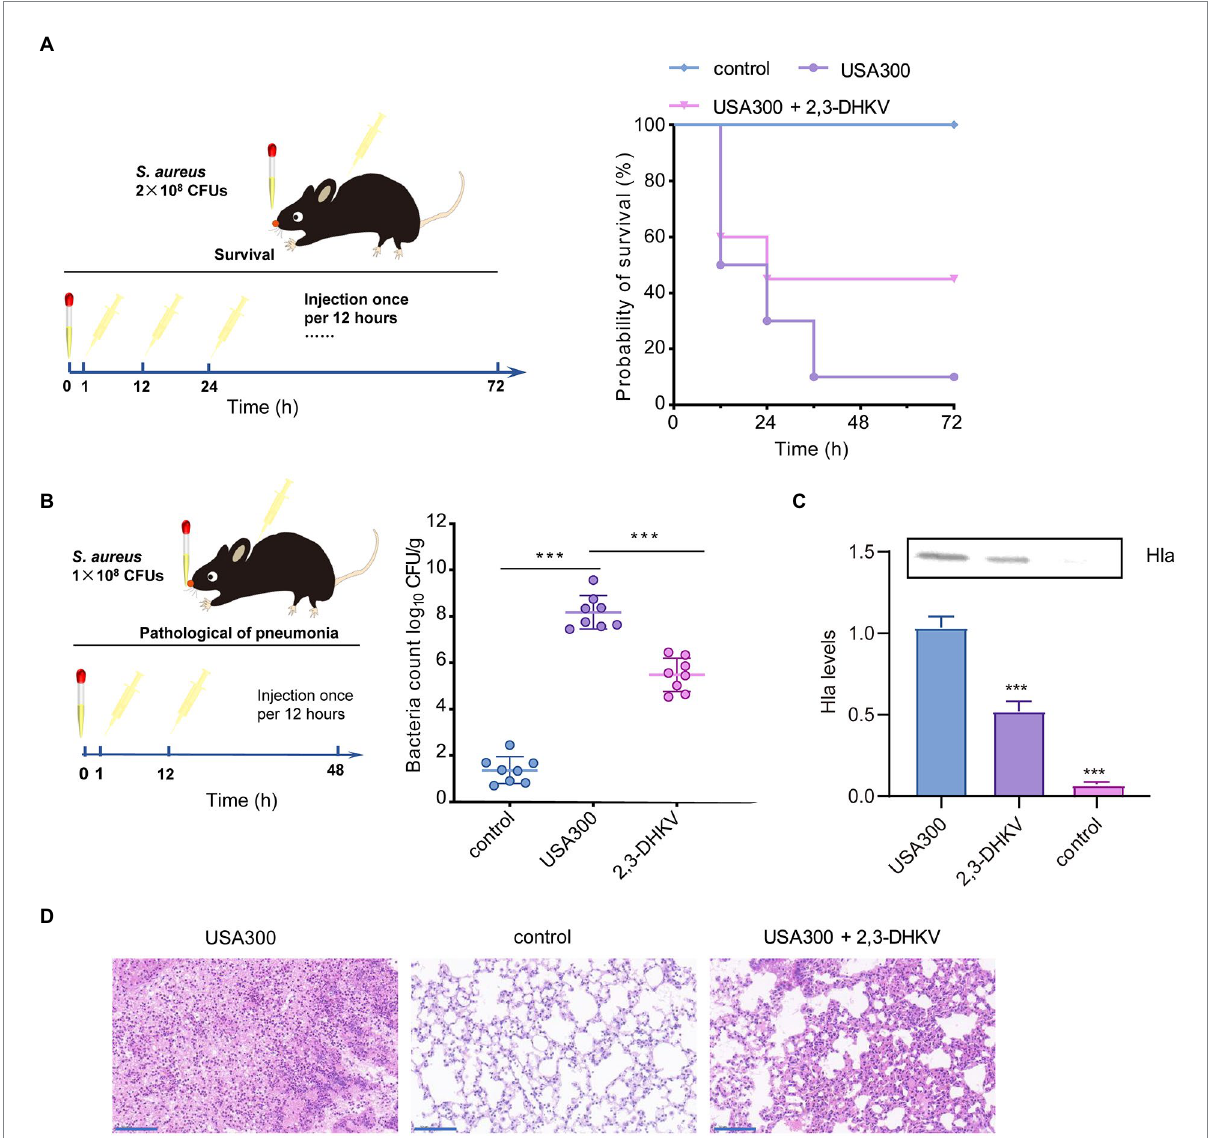
FIGURE 5 2,3-DHKV protects against S. aureus pneumonia infection in mice. (A) The protective effect of 2,3-DHKV on infected mice was evaluated based on the survival rate that was recorded at 12 h intervals for 72 h ( n = 10), and the uninfected group acted as a positive control. (B) The bacterial load of murine lungs treated with or without 40 mg/kg 2,3-DHKV, and the uninfected group served as a positive control ( n = 8). (C) Hla level in alveolar lavage fluid of mice treated or untreated with 2,3-DHKV after infection with S. aureus USA300. (D) Histopathological analysis (H&E staining) of S. aureus -infected mouse lungs with or without 2,3-DHKV treatment. Scale bar, 100 μ m. The data is provided as mean ± SD, *** p <